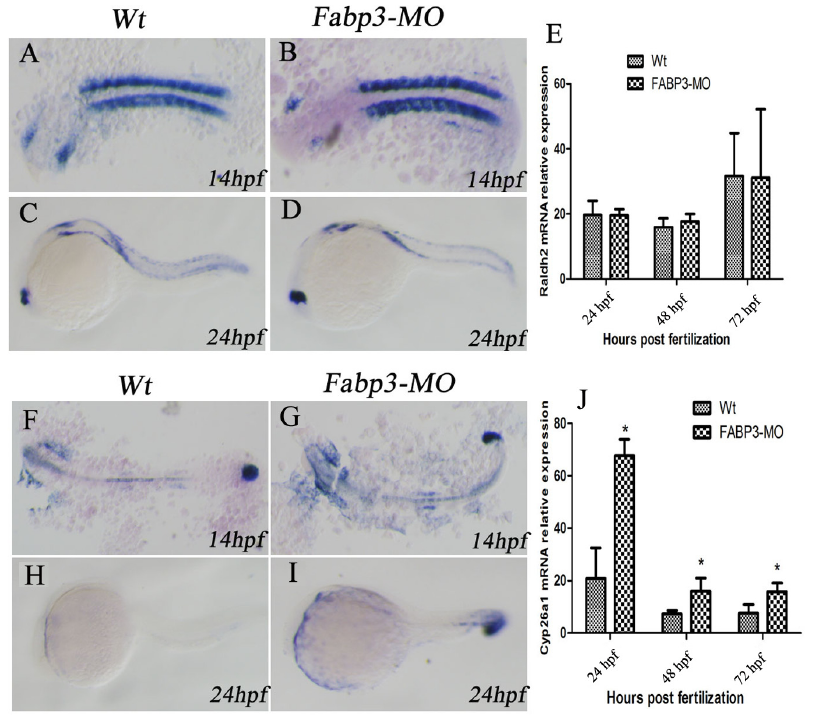
Figure 5. FABP3-MO alters the retinoic acid signaling pathway. Raldh2 expression was not significantly different in FABP3-MO injected zebrafish, as visualized by in situ hybridization at 14 hpf ( B ) and 24 hpf ( D ), compared with Wt controls at 14 hpf ( A ) and 24 hpf ( C ), respectively. Stable expression levels of Raldh2 were also confirmed by real-time PCR ( E ). Cyp26a1 expression was significantly upregulated in FABP3-MO injected zebrafish, as visualized by in situ hybridization at 14 hpf ( G ) and 24 hpf ( I ), compared with Wt controls at 14 hpf ( F ) and 24 hpf ( H ), respectively. Increased expression levels of Cyp26a1 were confirmed by real-time PCR ( J ).* p <